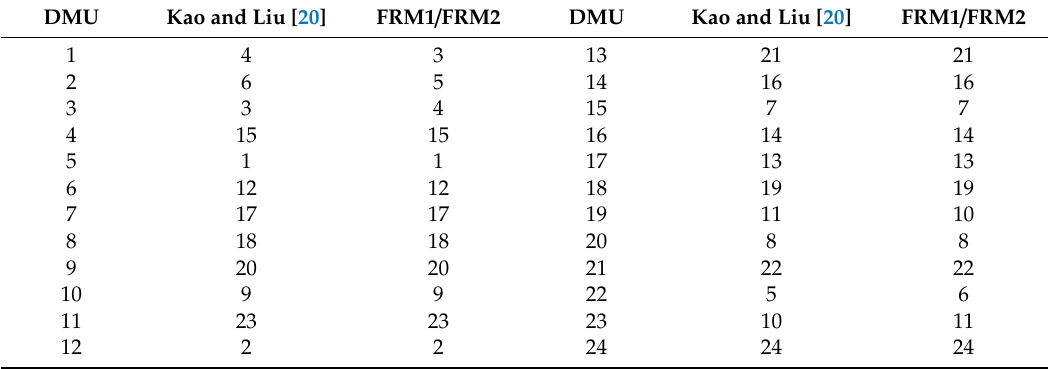
Table 2. Ranking of Kao and Liu [20] and proposed methods for dataset 1.